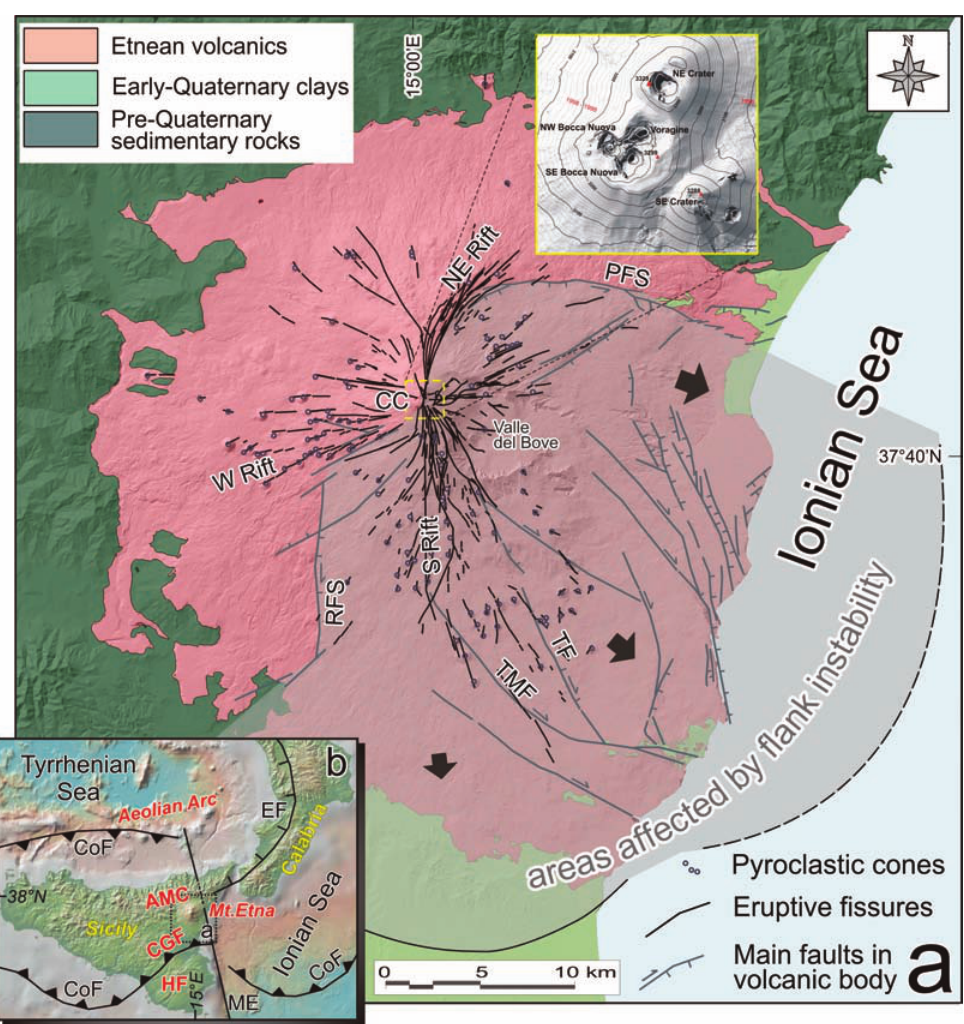
Figure 1. Simplified structural map of Mount Etna (a), showing the distribution of Etnean volcanics, eruptive fissures and major pyroclastic cones produced by flank eruptions, significant fault systems, and the sector of the volcano that is affected by flank instability-induced displacement. Arrows indicate directions of movement for different portions of the mobile flank sector. Inset at top: LIDAR-derived digital elevation model of the summit crater complex [Neri et al. 2008b]. CC, central craters; PFS, Pernicana fault system; RFS, Ragalna fault system; TF, Trecastagni fault; TMF, Tremestieri fault. The pre ‐ Quaternary sedimentary rocks include the AMC and CGF deposits. The regional tectonic context is shown in inset (b); AMC, Appenine ‐ Maghrebian Chain; CGF, Gela ‐ Catania foredeep; HF, Hyblean foreland; ME, Malta Escarpment; CoF, compressional front; EF, extensional front; the area outlined by the broken line is the area enlarged in